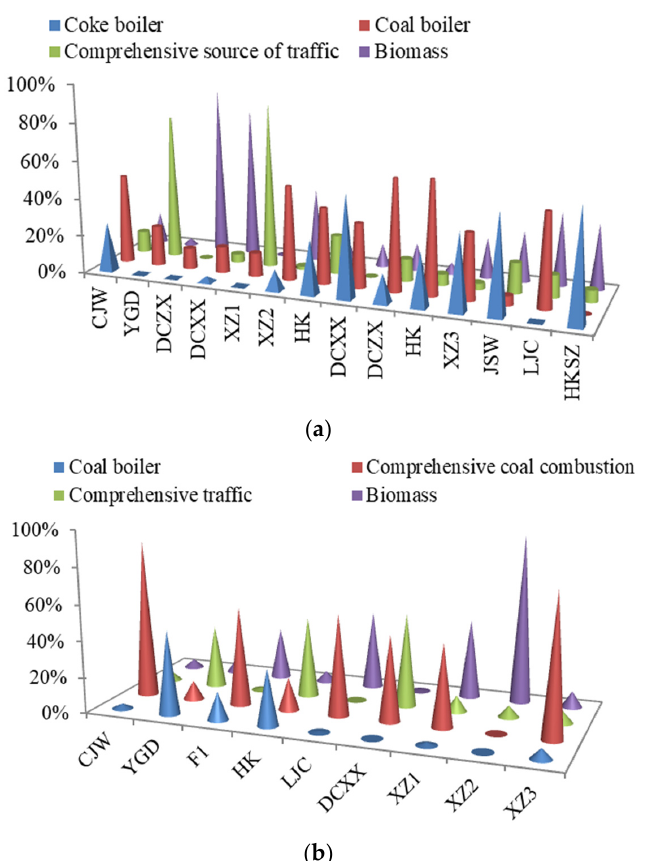
Figure 6. Contribution of different sources of PAHs in soils ( a ) and sediments ( b ) at each location in the Poyang Lake District study area.